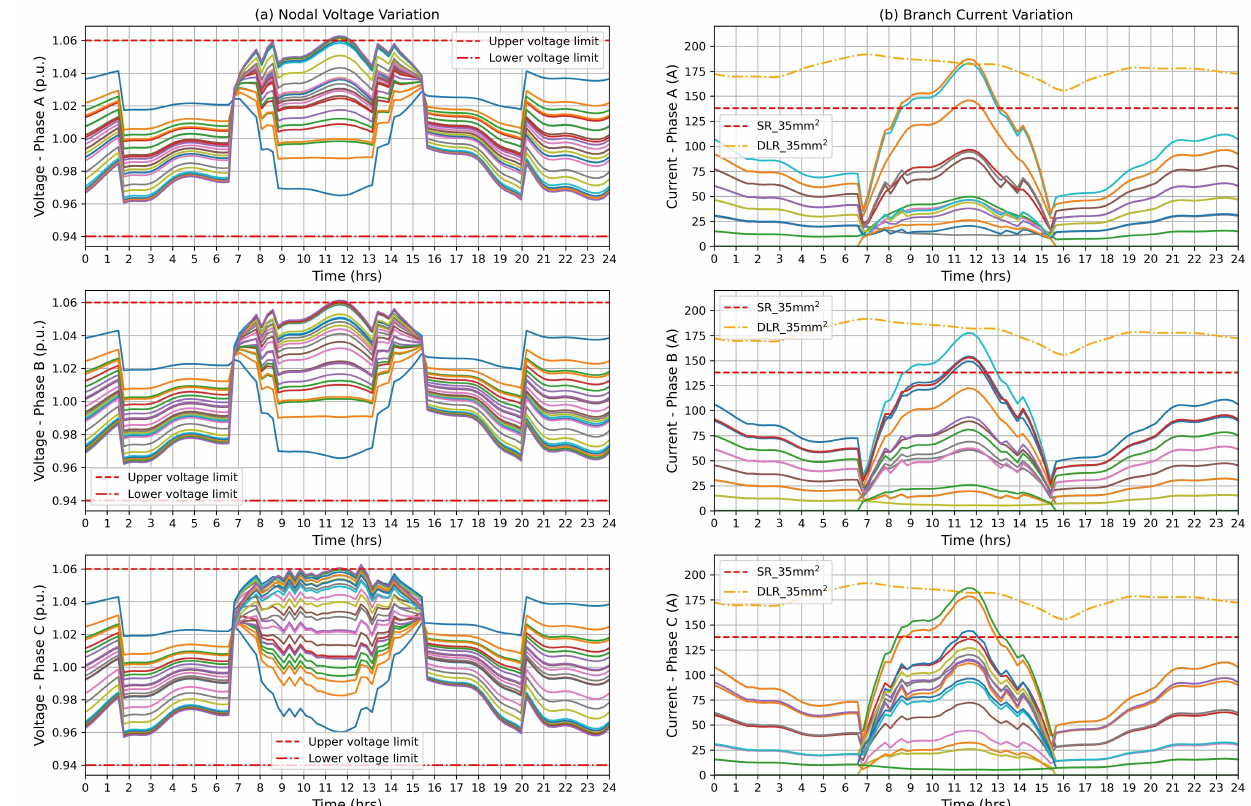
Figure 17. ( a ) Nodal voltage variation; and ( b ) branch current variation during the simulation period with RPC and OLTC voltage regulation after